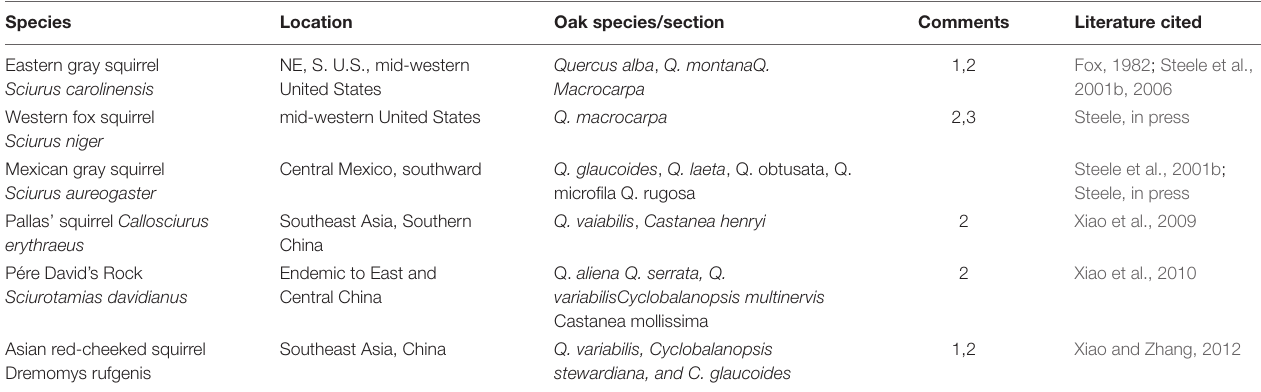
TABLE 1 | Summary of squirrels that perform embryo excision on early germinating white oaks.